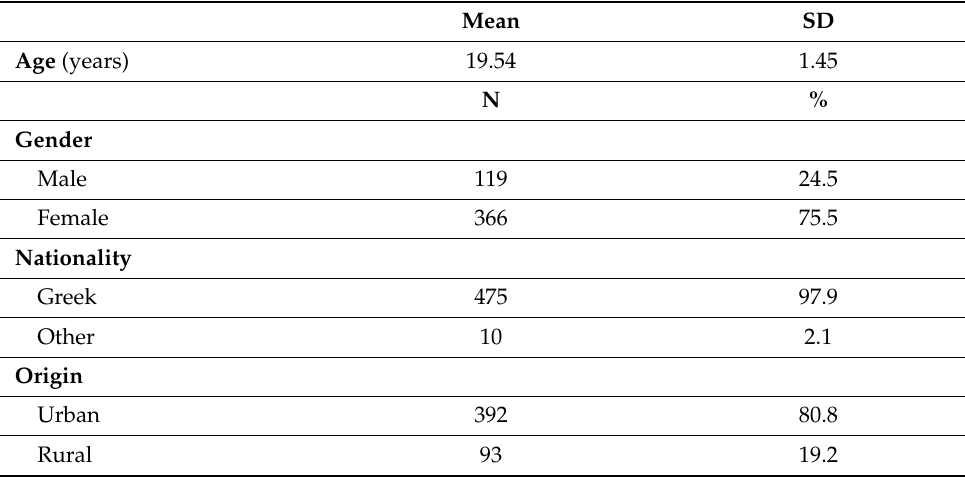
Table 1. Socio-demographic characteristics of participants (n =